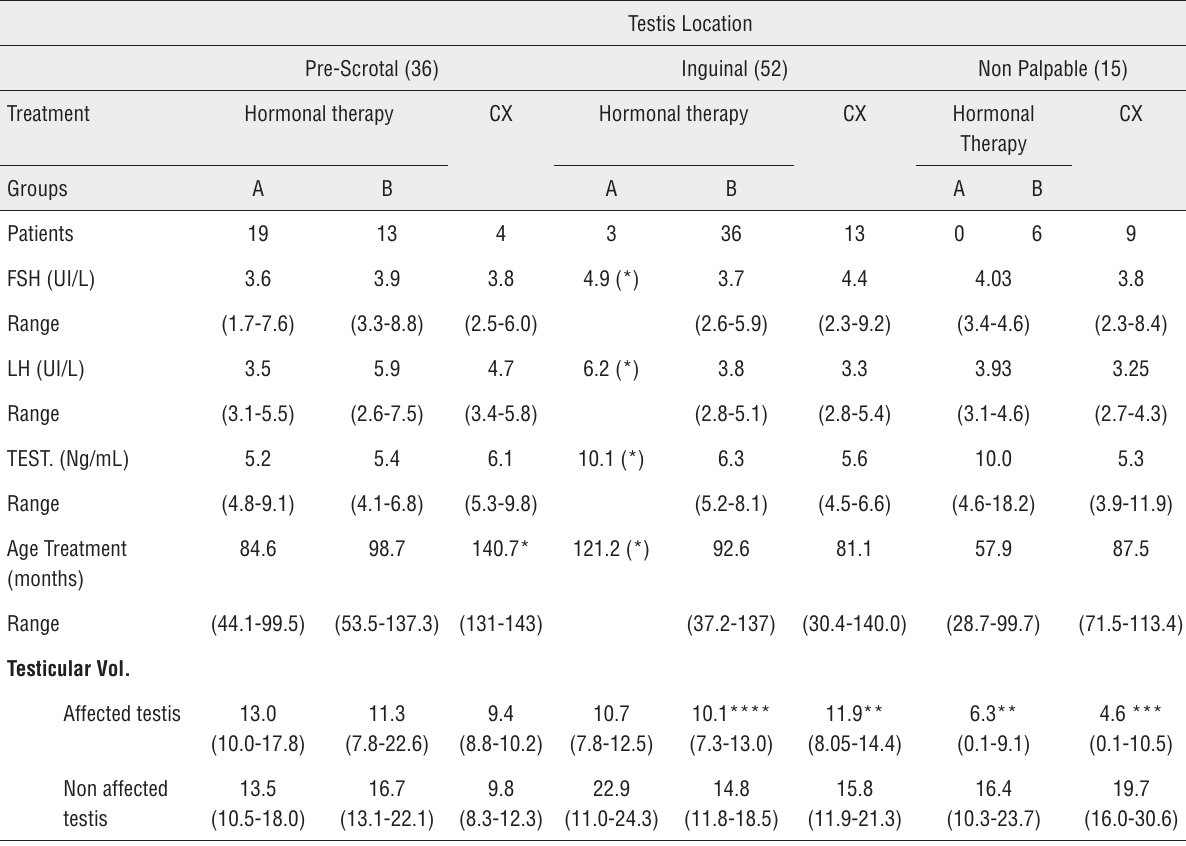
Table 1 - Unilateral cryptorchidism (n=103). Features based on testis location and therapy used (A-only hormonal treatment; B-hormonal first and surgery later; CX – surgery alone;